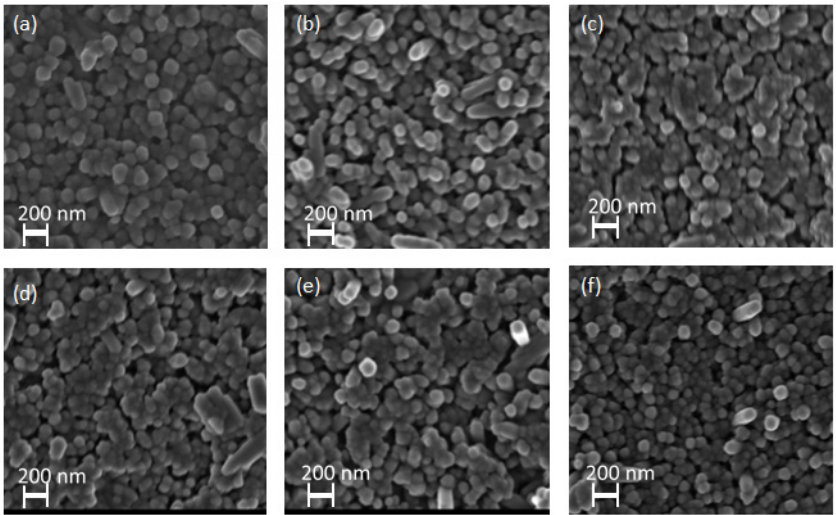
Figure 3. SEM images of ( a ) pristine hematite NRs, ( b ) 3 mM Zn-doped NRs, and ( c ) 3 mM Zn/3 mM Ni, ( d ) 3 mM Zn/5 mM Ni, ( e ) 3 mM Zn/7 mM Ni, and ( f ) 3 mM Zn/9 mM Ni co-doped